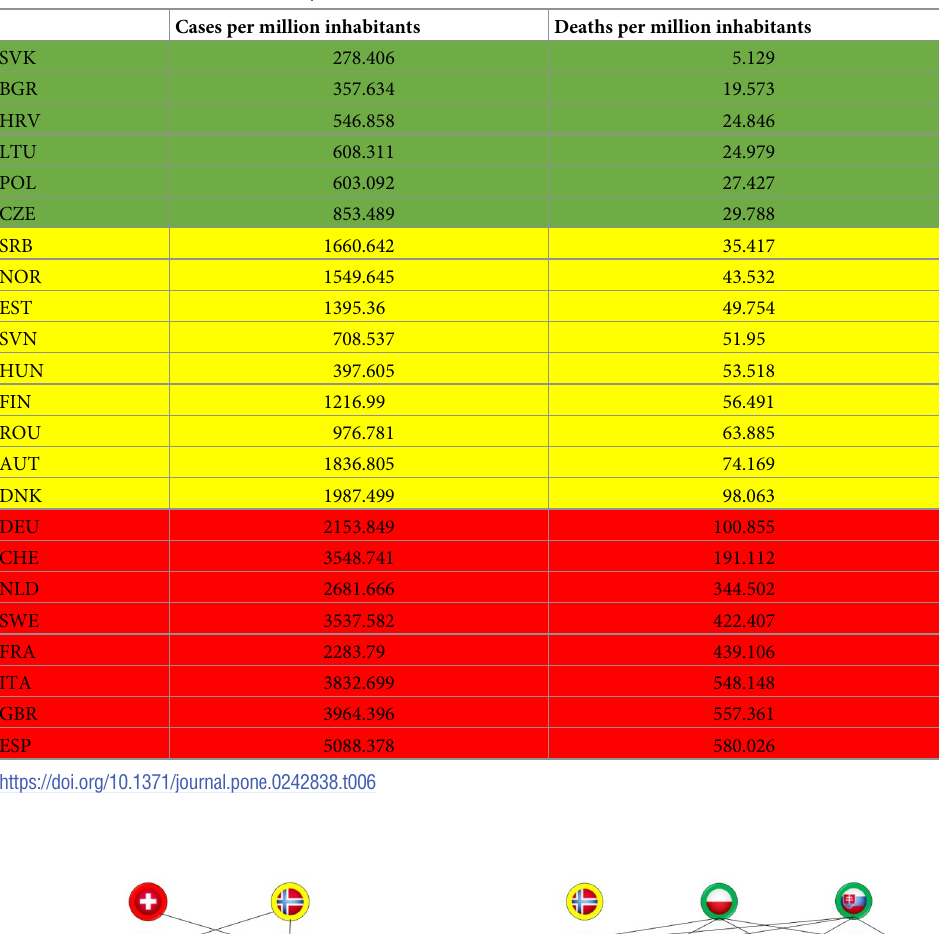
Table 6. Countries in terms of severity of initial outbreak.